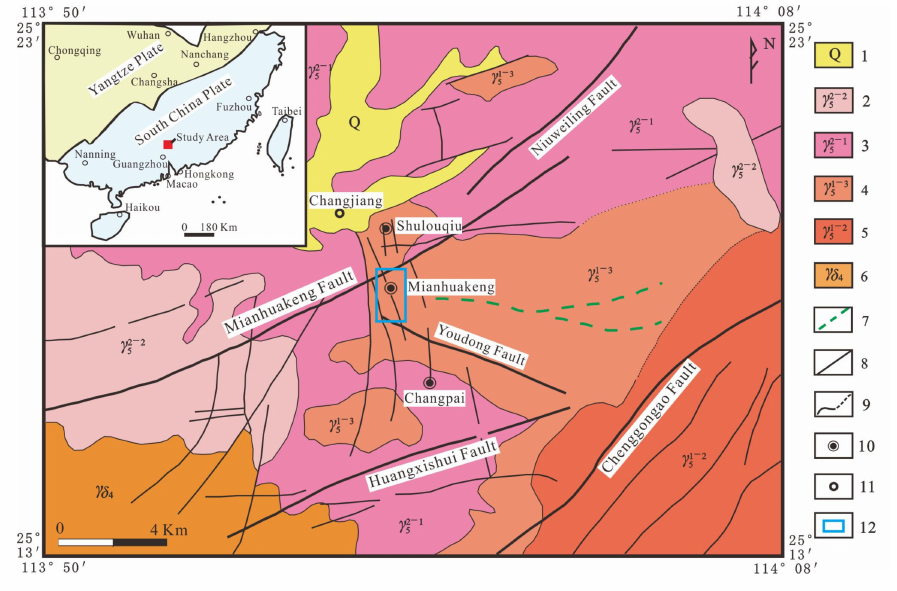
Figure 1. Sketch geological map of the Changjiang uranium area (modified from Huang et al. 2014 [23]). 1—Quaternary; 2—Medium-grained (porphyritic) biotite-muscovite granite; 3—Medium–coarse-grained porphyritic biotite monzonitic granite; 4—Medium–fine-grained biotite- muscovite granite; 5—Medium-grained (porphyritic) biotite granite; 6—Granodiorite; 7—Diabase; 8—Fault; 9—Measured and inferred geological boundaries; 10—Uranium deposit; 11—Place mark; and 12—Mianhuakeng deposit area.